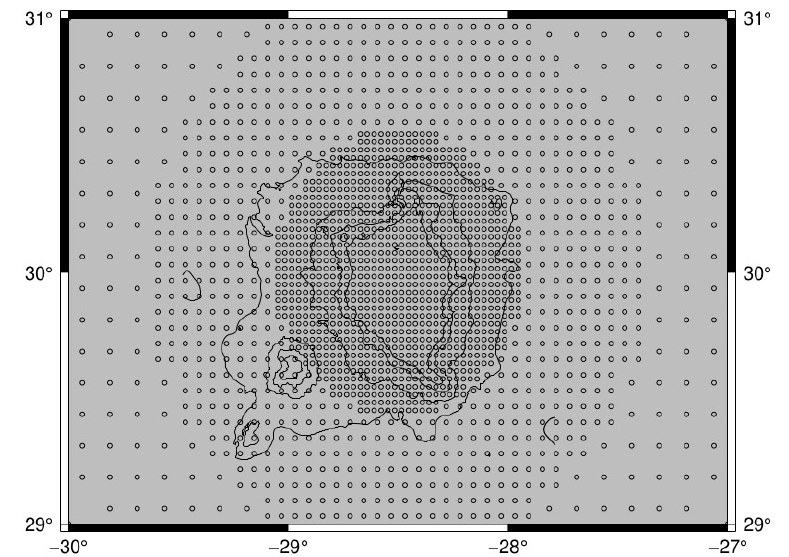
Figure 12. Irregular grid used to estimate GM bathymetry.